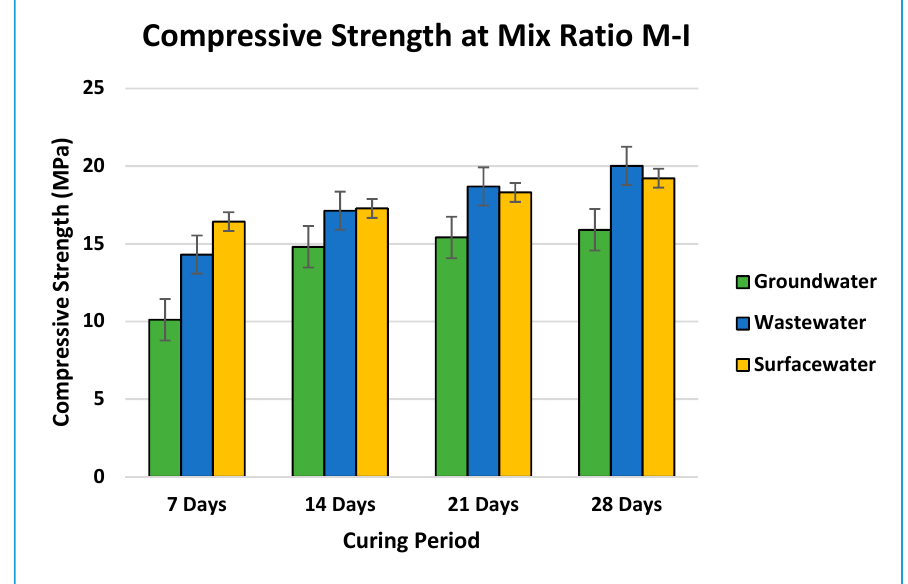
Figure 4. Cylinder compressive strength of concrete for the ratio M-I (1:2:4).